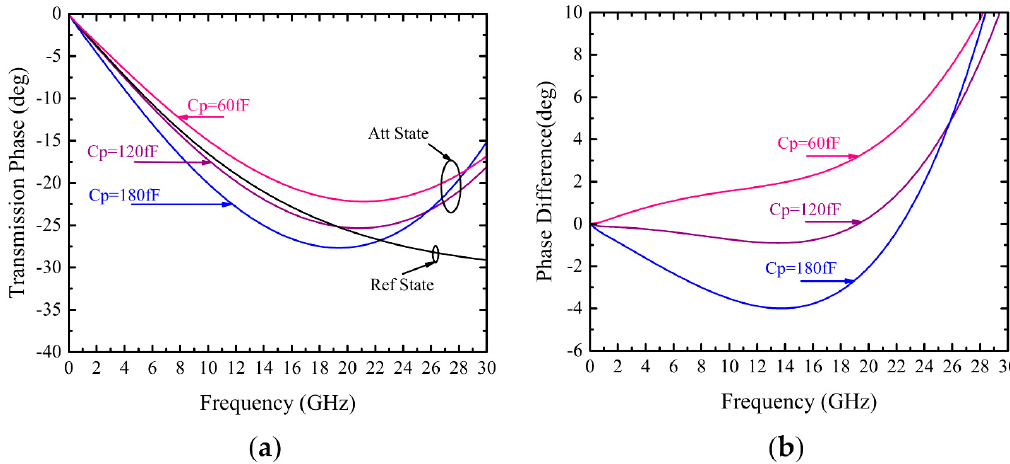
Figure 4. ( a ) The simulated transmission phase results of the proposed T-type attenuator topology of reference and attenuation states with various C p value; ( b ) the phase difference of reference and attenuation states with various C p value.